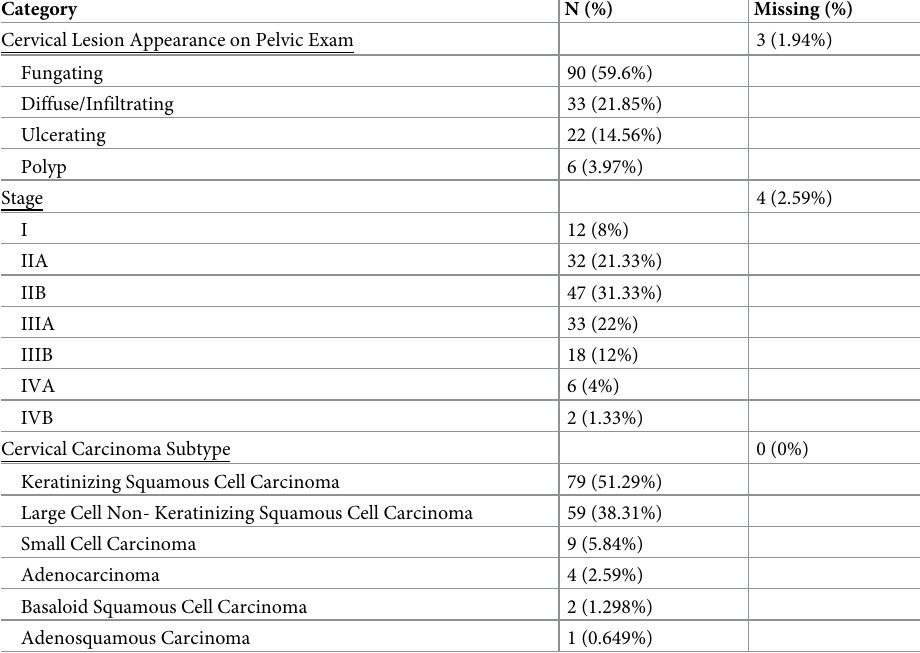
Table 3. Selected objective clinical features of 154 cervical cancer cases at the Jimma University Teaching Hospi- tal, Ethiopia from January 2008—December